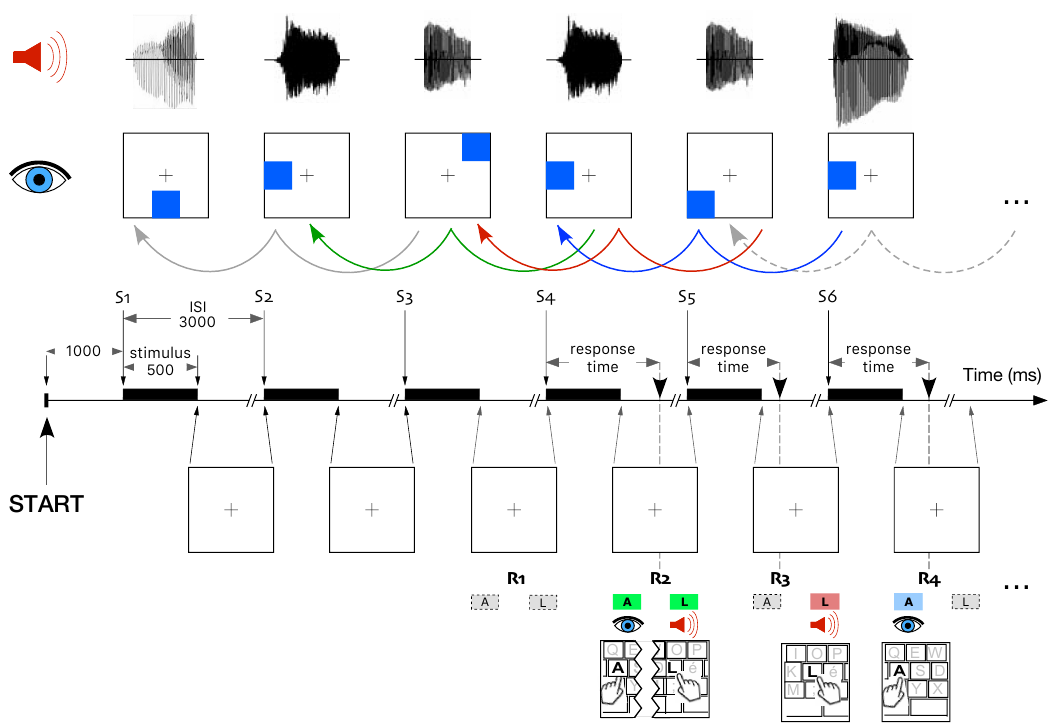
Figure 1. Level n = 2 of the dual n -back task. Each stimulus was composed by an auditory and a visual cue presented during 500 ms. This means the participants had to compare the third stimulus (S3) with the first one (S1), S4 with S2, S5 with S3, and so on. For the first correct response (R1), no stimuli matched those presented two trials back in time and no key press was requested. For R2, both auditory and visual stimuli matched the target (S4 identical to S2, green arrow)), such that both “A” and “L” key were pressed. For R3, only the auditory stimulus matched the target (red arrow) and only the “L” key was pressed. For R4, only the visual stimulus matched the target (blue arrow) and only the “A” key was pressed. Notice that in this example only correct responses are